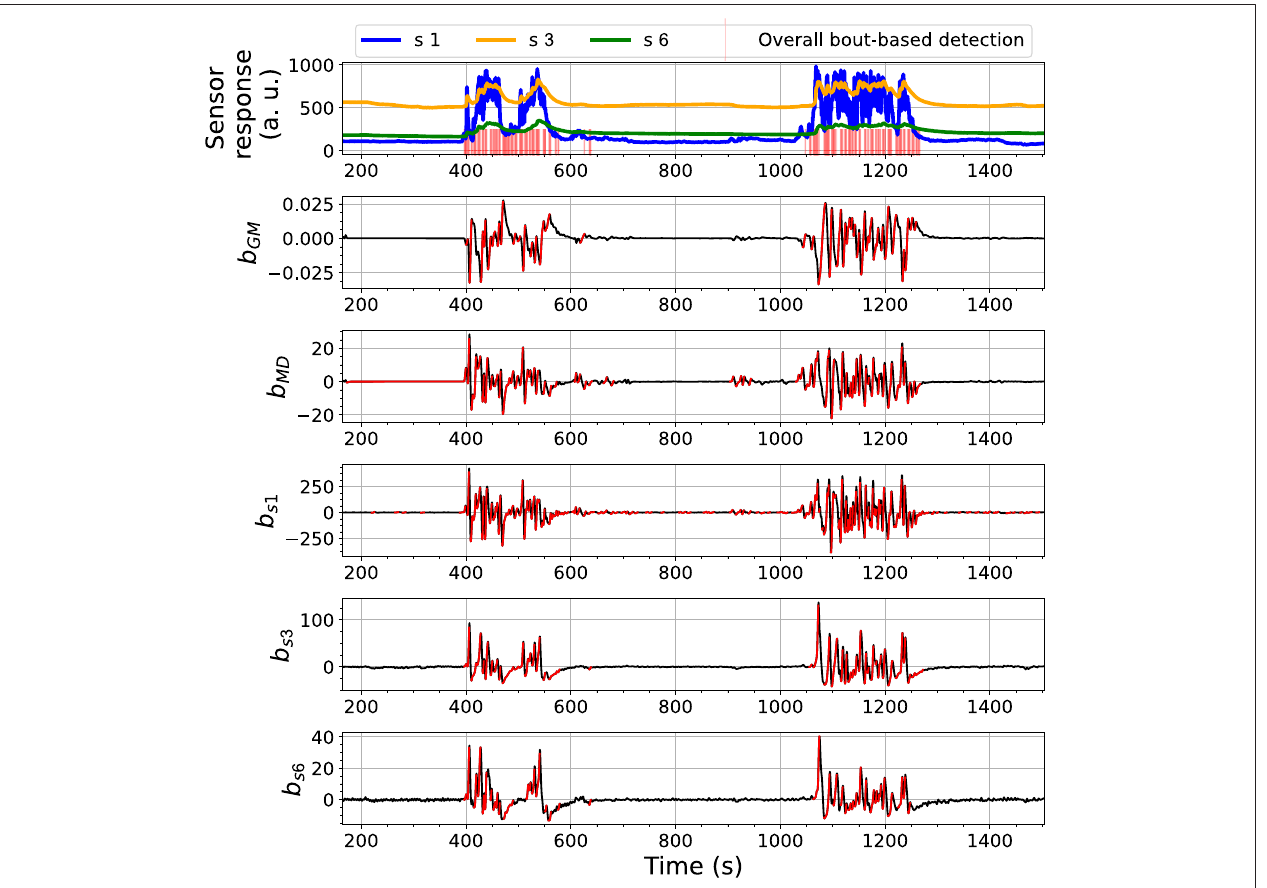
FIGURE 10 | Bout analysis and the prediction result of the Bout-Count Detection (BCD) model using ORU nose on the Exp. 2-source trial. The overall bout detection madebytheBCDmodelisvisualized inthetopsub fi gure,wheretime stepswithinthedurationofafoundbout aremarkedwithred vertical lines.Thedetected and fi ltered bouts in each signal are highlighted in red in the rest sub fi